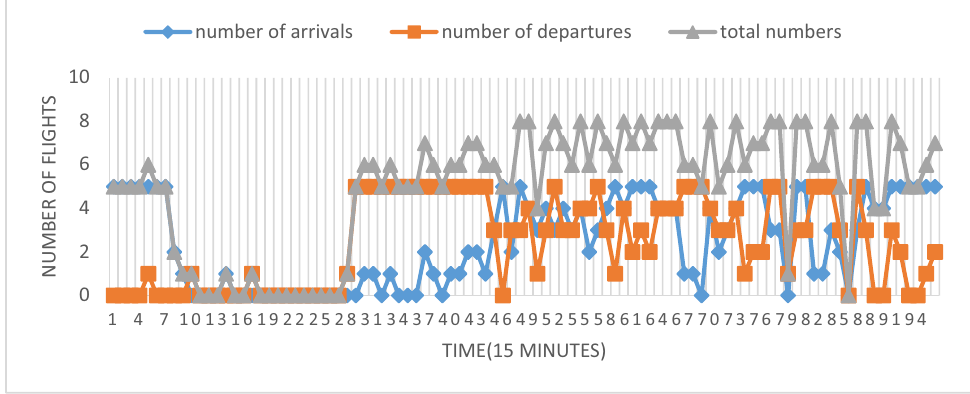
Figure 7: Arrival and departure fl ight slot distribution in every 15 min in the optimized fl ight schedule by Scheme 1 when δ 1 = .